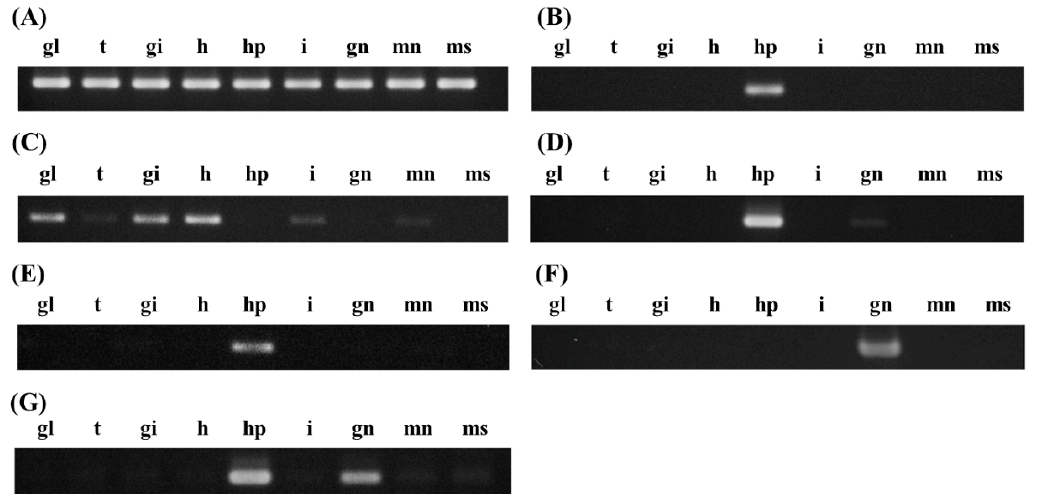
Figure 3. Tissue-specific distribution of transcripts whose differential expression was associated with the growth of Pacific abalone. RT-PCR was carried out using primers specific for ribosomal protein L3 (Tsc1, A ); and differentially-expressed candidate genes encoding transcripts similar to incilarin A (Tsc2, B ); perlucin (Tsc5, C ); transforming growth factor- β -induced protein ig-h3 (Tsc8, D ); tomoregulin-2 (Tsc20, E ); vitelline envelope zona pellucida domain 4 (Tsc34, F ); and defensin (Tsc35, G ). Total RNAs isolated from ganglion (gl), tentacle (t), gill (gi), heart (h), hepatopancreas (hp), intestine (i), gonad (gn), mantle (mn), and muscle (ms) were used for cDNA synthesis, followed by PCR amplification.